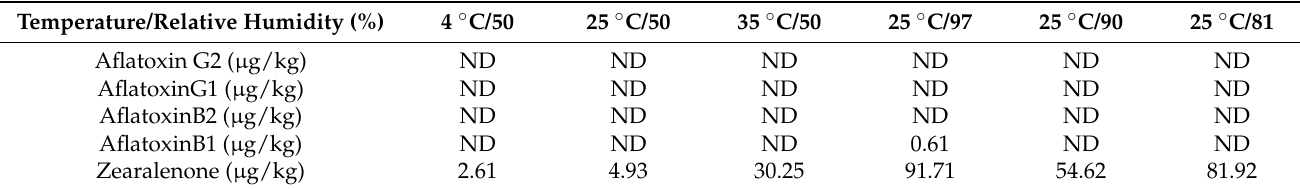
Figure 5. Changes of TAGs content under long-term storage. Table 3. Changes of aflatoxins and zearalenone under different storage